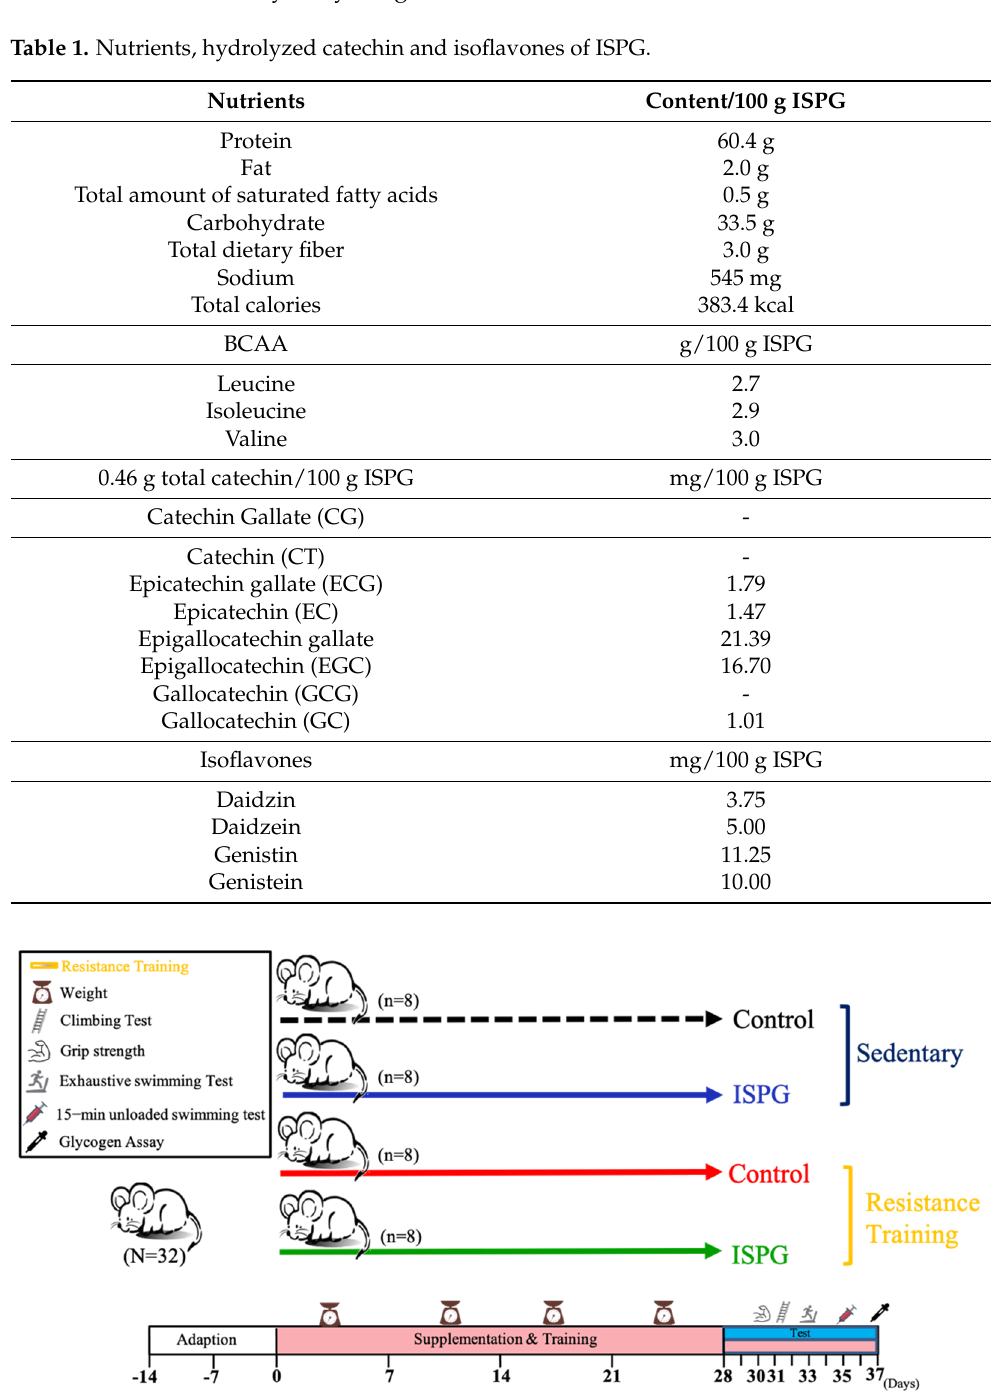
Figure 1. Experimental design.